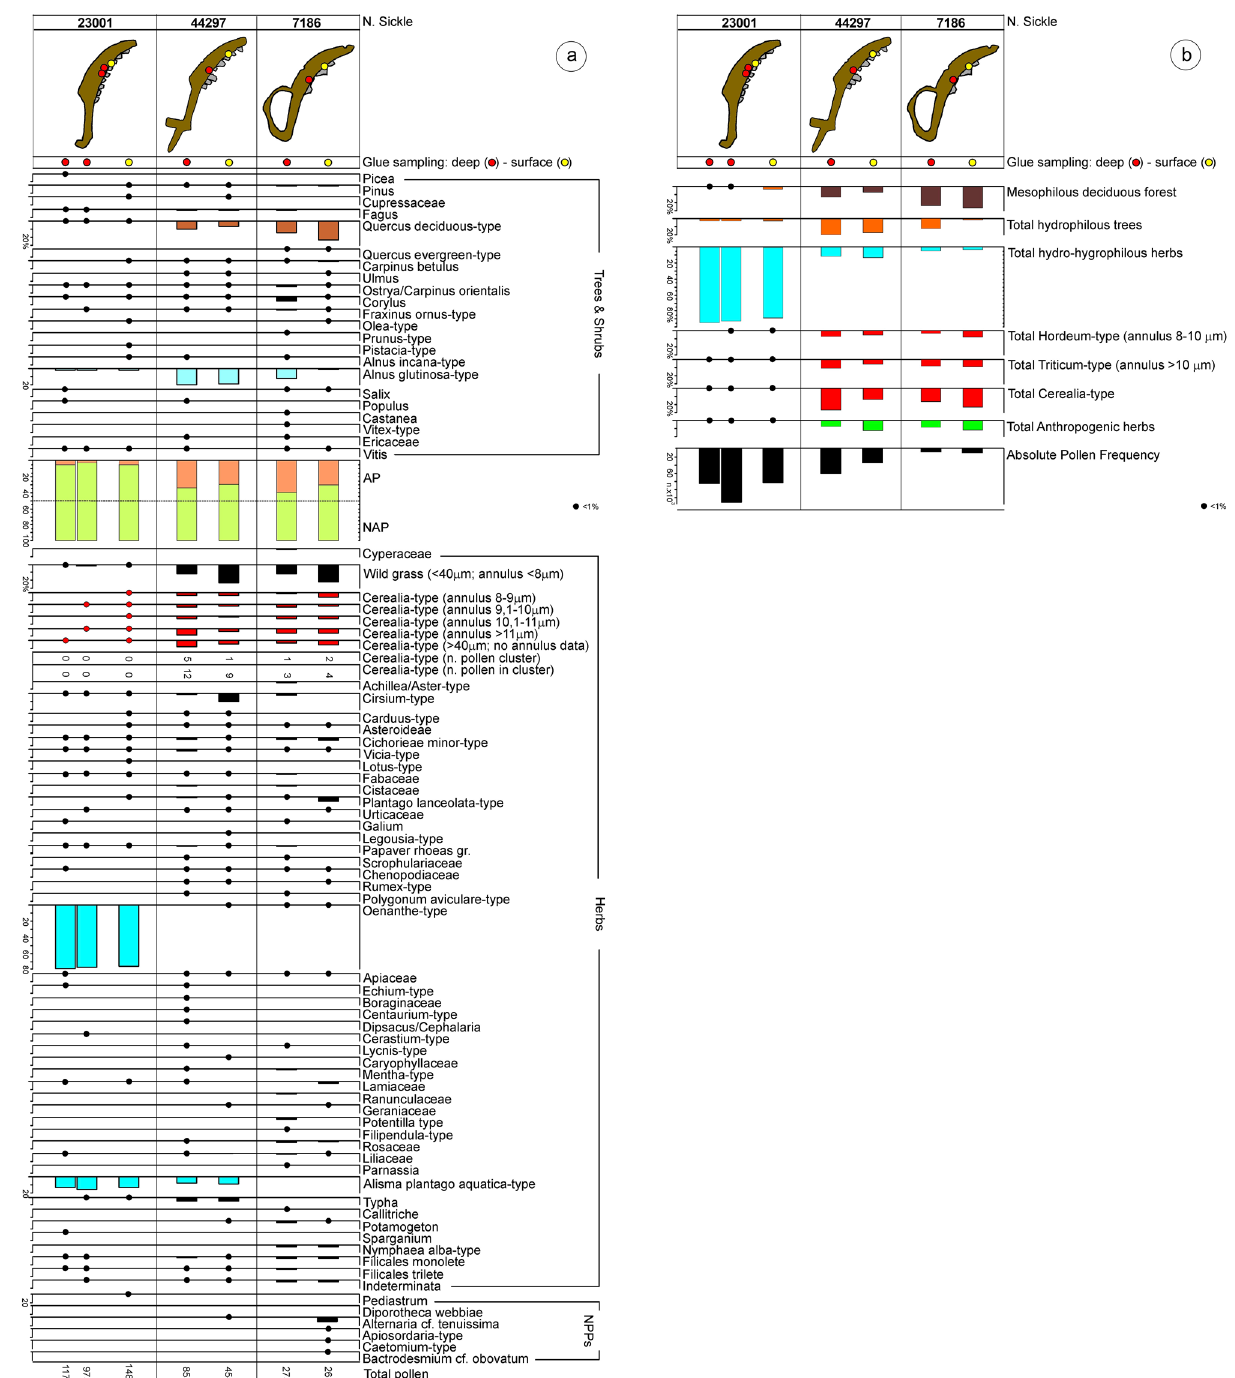
Figure 6. ( a ) Pollen percentage diagram of Arboreal Pollen (AP), Non-Arboreal Pollen (NAP) taxa, and non- pollen palynomorphs (NPPs) in the adhesive on three sickles from La Marmotta. NPP values are expressed as percentages of total pollen; ( b ) pollen percentage diagram of selected categories of ecological and anthropogenic interest in the adhesive on three sickles from La